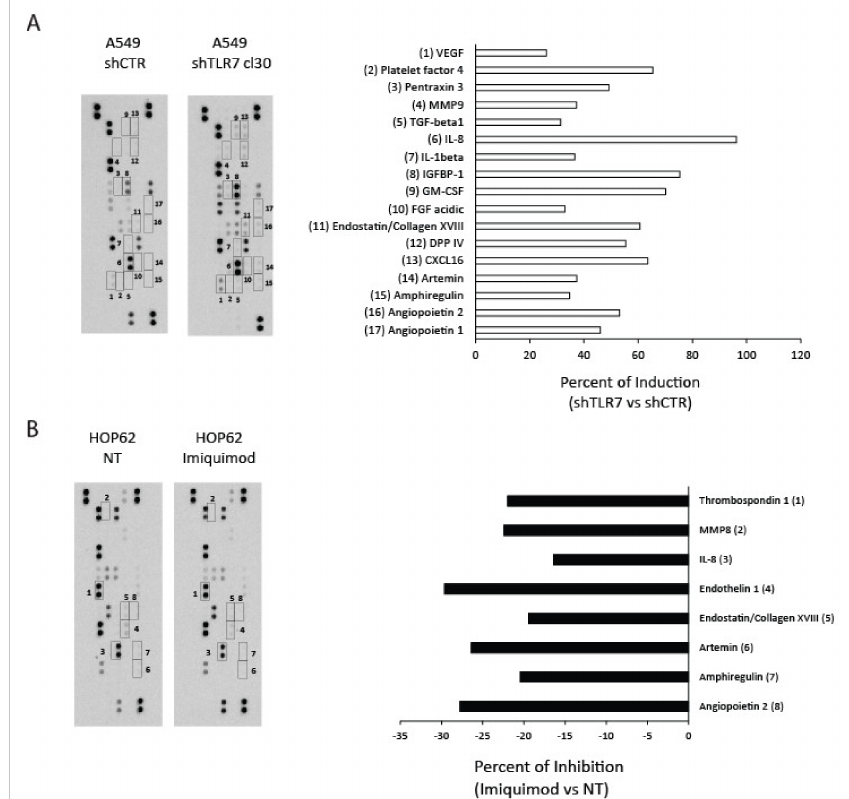
Figure 2. Effects of TLR7 modulation on NSCLC angiogenic potential. Analysis of proteins in conditioned media (CM) from A549 shCTR and shTLR7 clone 30 ( A ) or HOP62 treated or untreated with imiquimod (1 µ g/mL) ( B ) using angiogenesis associated protein antibody arrays. The array images and the relative quantitative profiles of protein levels are